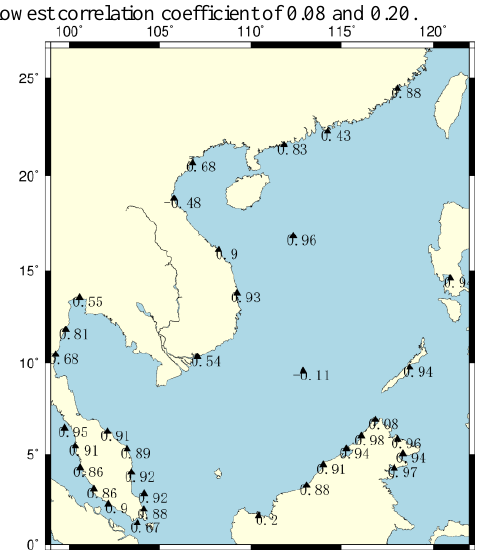
Figure 3. Correlation of observations between satellite altimetry and tide gauge data in tide stations